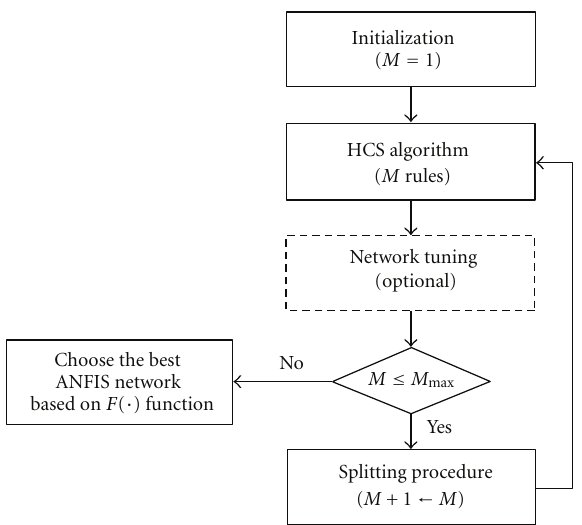
Figure 1: Flow chart of the HHCS algorithm. The tuning of ANFIS networks is an optional step, as discussed in Section